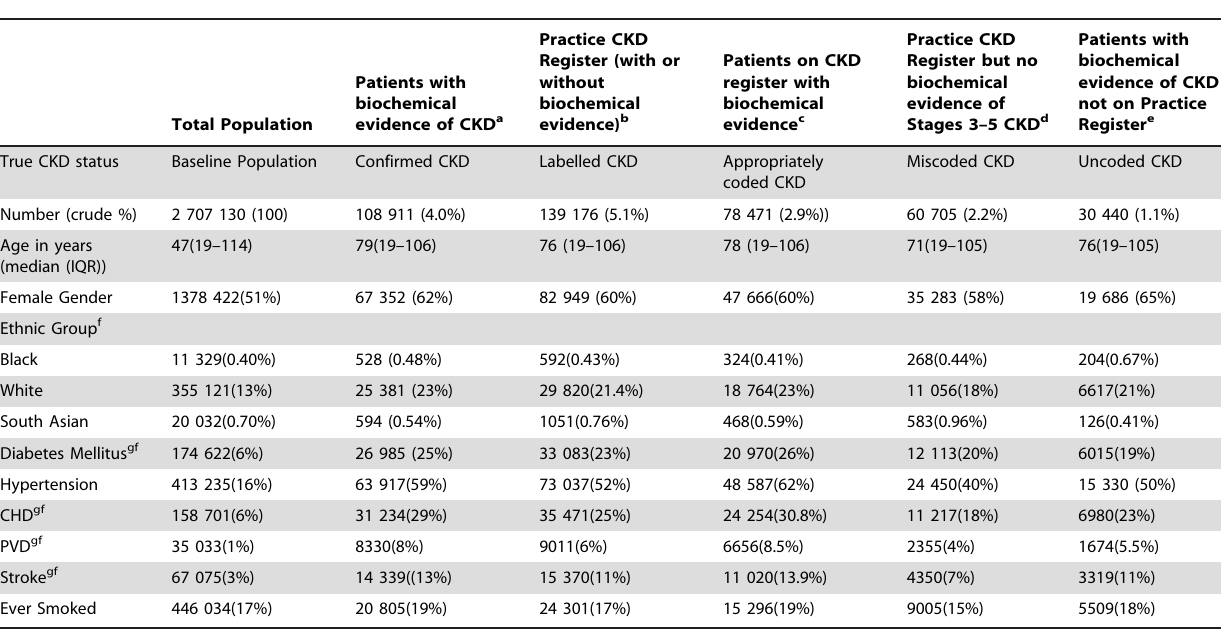
Table 1. Demographics of CKD patients between 1st January 2008 to 1st April 2009 (The proportions in brackets are not adjusted and crude percentages).